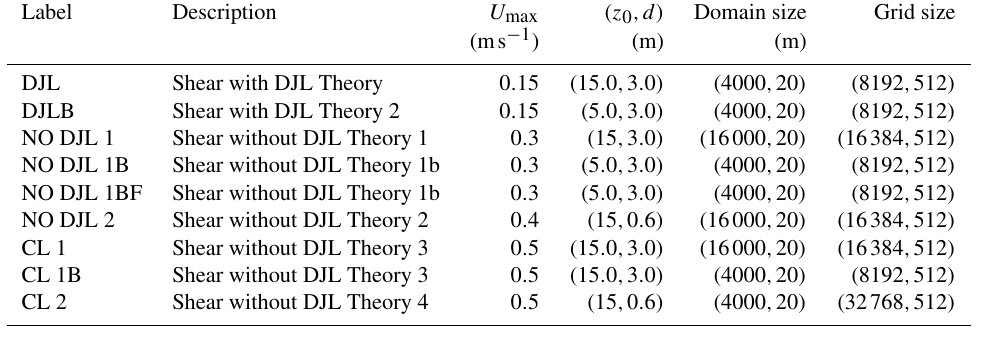
Table 1. Cases considered throughout the paper, including case label and their dimensional parameters. Label